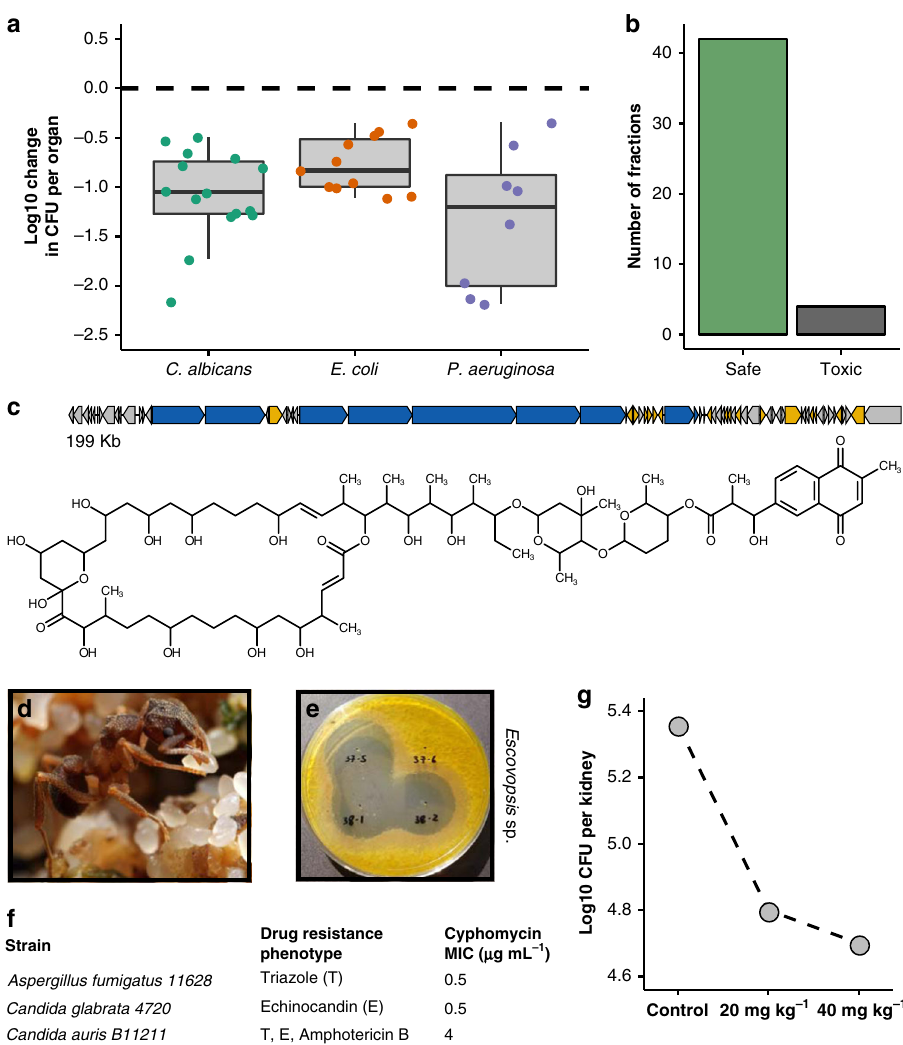
Fig. 5 Insect-associated Streptomyces are a source of active antimicrobials. a Fractionated extracts from insect microbiomes are active in multiple murine models of drug-resistant infection. Less infective burden is seen in intraperitoneally treated mice after 8 h of infection. Each dot represents a unique fraction in one mouse study. ( n = 15, 11, and 8 for C. albicans , E. coli , and P. aeruginosa models, respectively; center, median; box, upper and lower quantiles; whiskers, 1.5× interquartile range. b Most fractions from insect microbiomes show no hemolysis in cell-based assays. Safe indicates no toxicity at >100× concentration associated with ef fi cacy. c The antifungal cyphomycin is produced by Streptomyces isolated from d the fungus-growing ant Cyphomyrmex sp. Photo credit: Alexander Wild e Cyphomycin-containing fractions show potency against the ant pathogen Escovopsis sp. (top left, bottom). f Puri fi ed cyphomycin exhibits potency against resistant pathogens. g Mouse candidiasis ( C. albicans ) models showcase reduced infection and a dose-like response to cyphomycin. Dots indicate individual